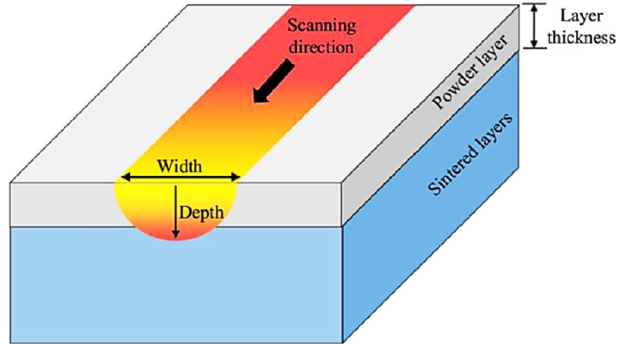
Figure 9. Schematic view of the melt pool during laser irradiation. Reproduced with permission from [75].